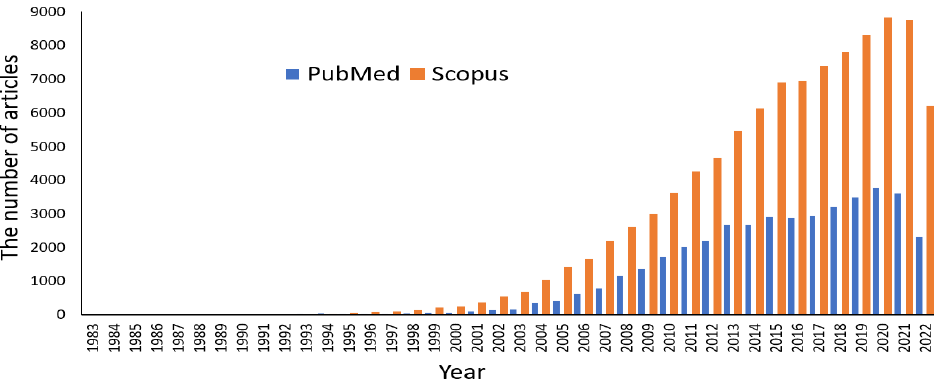
Figure 1. The number of articles published per year in PubMed (Medline) and Scopus databases under the search phrase “magnetic nanoparticle”. The lower number of papers in 2022 is because the literature search was conducted in September 2022. An upward trend is expected for 2022. PubMed comprises biomedical literature from the MEDLINE database and life science journals.